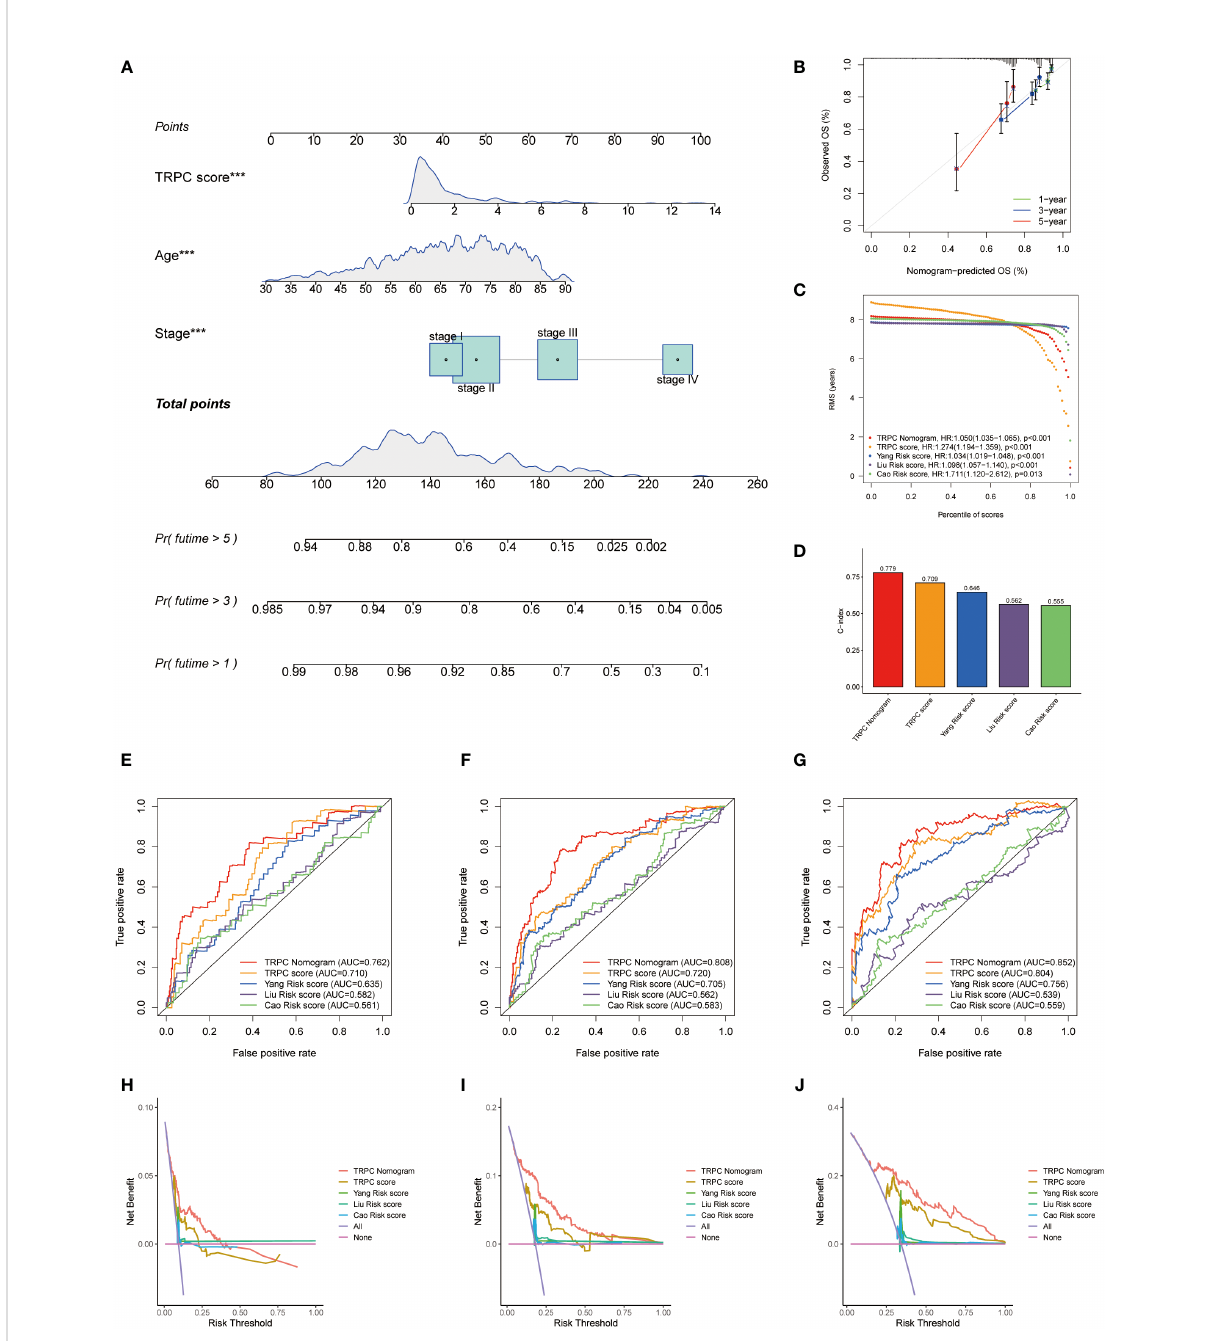
FIGURE 6 Development of a nomogram. (A) Nomogram to predict the survival of CRC patients based on the TRPC score. (B) Calibration plots of the nomogram for predicting the probability of OS in the 1-year, 3-year, and 5-years. Comparison of RMS (C) and C-index (D) among the TRPC nomogram, TRPC score, and published models of Yang, Liu, and Cao. The ROC curves (E-G) and decision curve analysis (H-J) at 1-, 3-, and 5- year OS for TRPC nomogram, TRPC score, and published models of Yang, Liu, and Cao. CRC, colorectal cancer; OS, overall survival; RMS, restricted mean survival; ROC, receiver operator characteristic; TRPC, transient receptor potential channels; ***P<